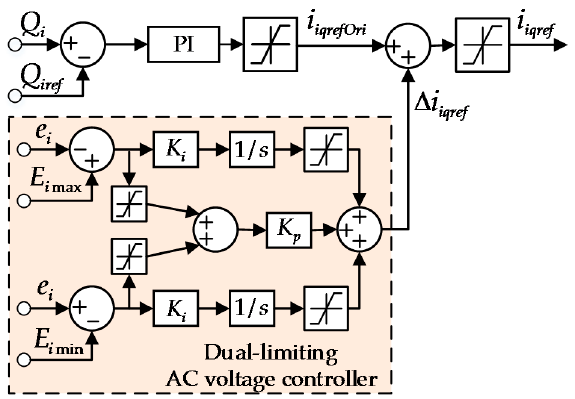
Figure 8. Control structures of reactive power controller.